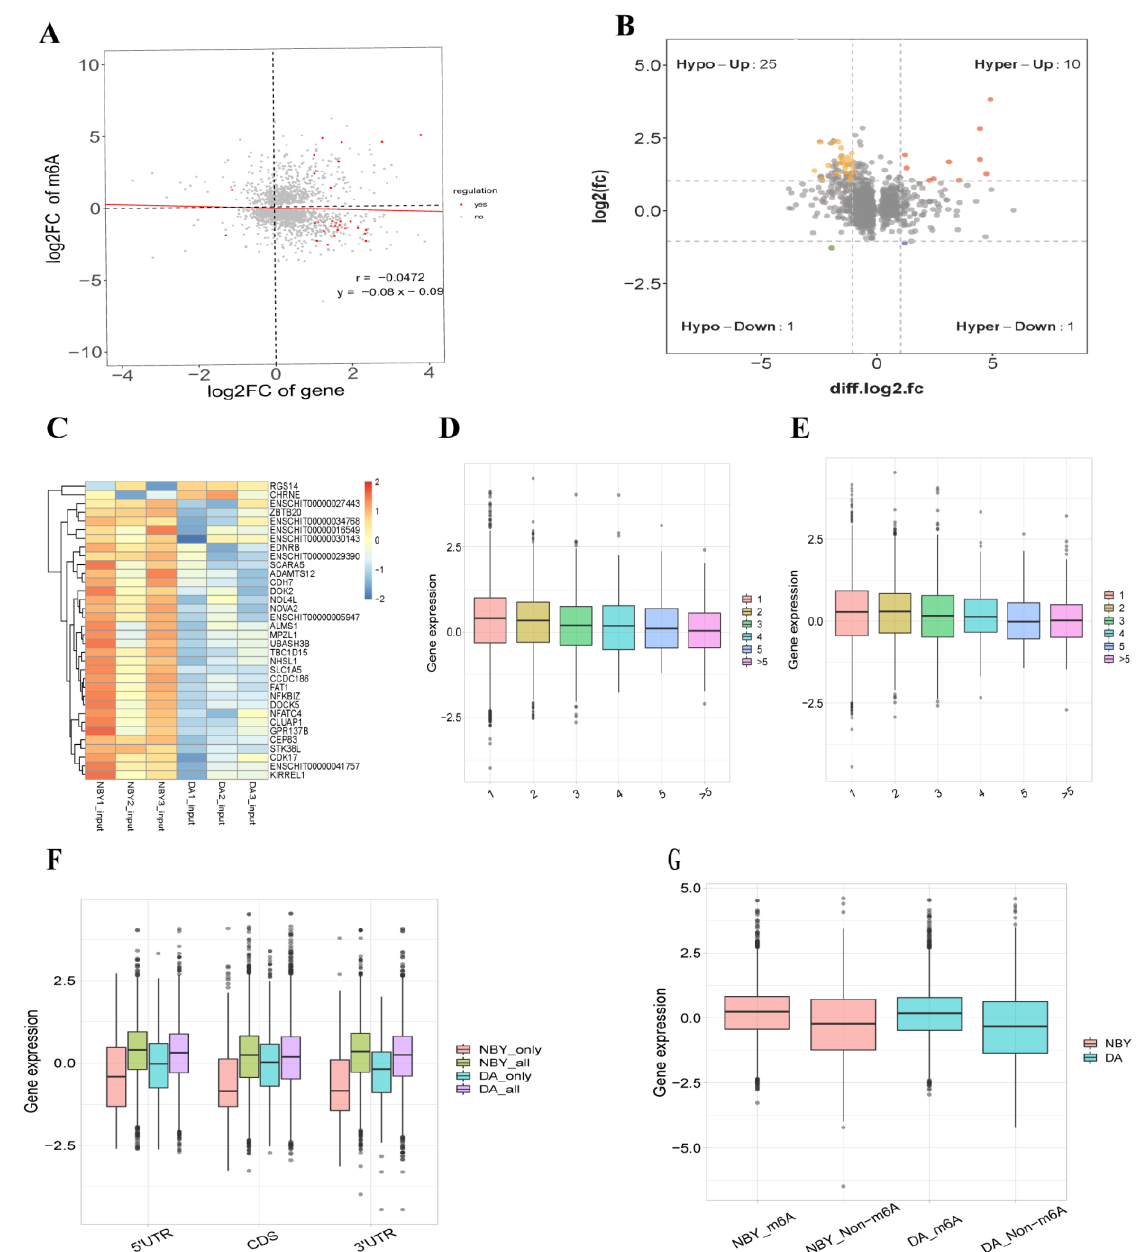
Figure 6. Conjoint analysis m6A-Seq and RNA-Seq data in DA and NBY. ( A ) Negative correlation of differentially methylated m6A peaks and gene expression level (r = − 0.0472; y = − 0.08x − 0.09). ( B ) Distribution of genes with a significant change in both differentially methylated m6A peaks and mRNA expression in DA and NBY. ( C ) Cluster heat maps of 34 genes with significant differences in m6A peaks and RNA level. ( D ) Expression levels of genes carrying the different number of m6A peaks in NBY. ( E ) Expression levels of genes carrying the different number of m6A peaks in DA. ( F ) The m6A modification sites and gene expression in all m6A peaks, NBY-unique peaks and DA-unique peaks. ( G ) Overall expression level of m6A methylated and non-m6A methylated genes in DA and NBY.